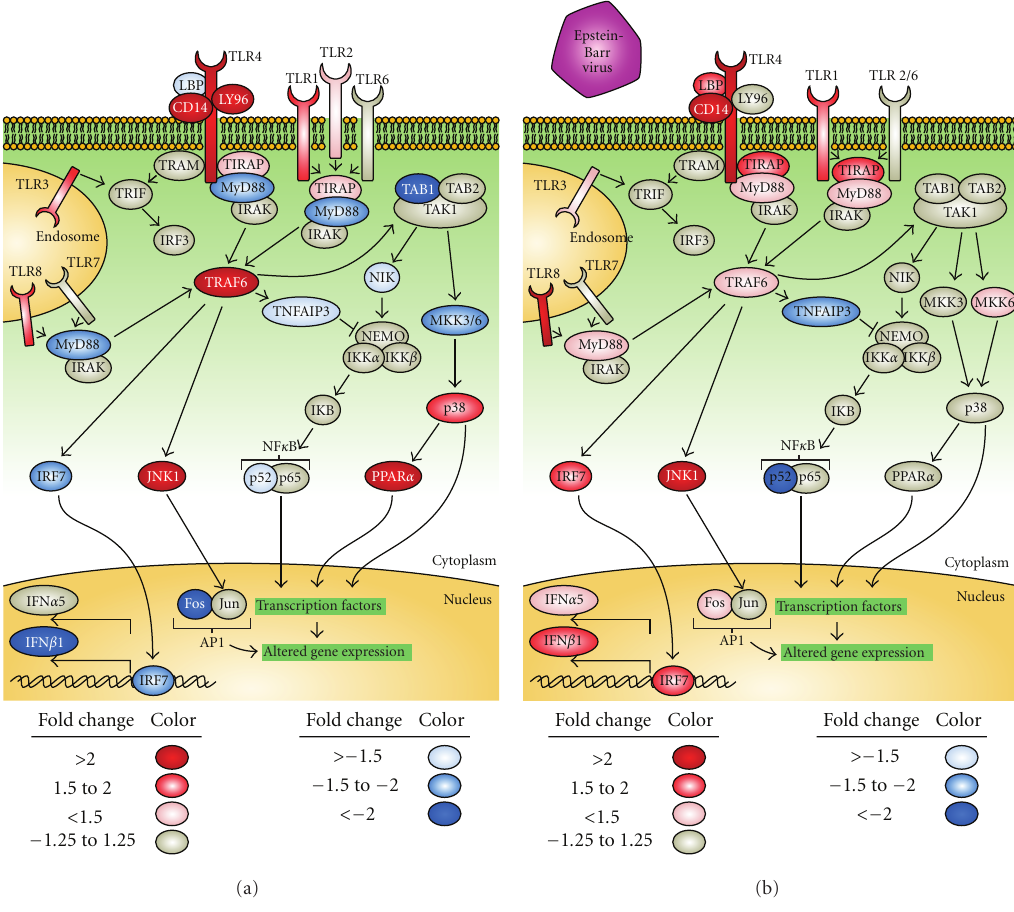
Figure 2: Association of the canonical Toll-like receptor pathway with IRF5 haplotype. Di ff erential regulation of the TLR pathway was seen using Ingenuity analysis ( P < 0 . 01). Unstimulated conditions are shown on the left, and EBV-exposed conditions on the right. Genes with altered expression based on haplotype are shown as either red or blue. IKB: inhibitor of NF κ B, IKK: IKB kinase, JNK: c-Jun N-terminal kinase, LBP: lipopolysaccharide-binding protein, MKK: mitogen activated protein kinase kinase, NIK: NF κ B inducing kinase, PPAR α : peroxisome proliferator-activated receptor α , TAB1: transforming growth factor β -activated kinase 1, TIRAP: Toll/IL-1 receptor domain containing adaptor protein, and TRAF6: tumor necrosis factor receptor-associated factor